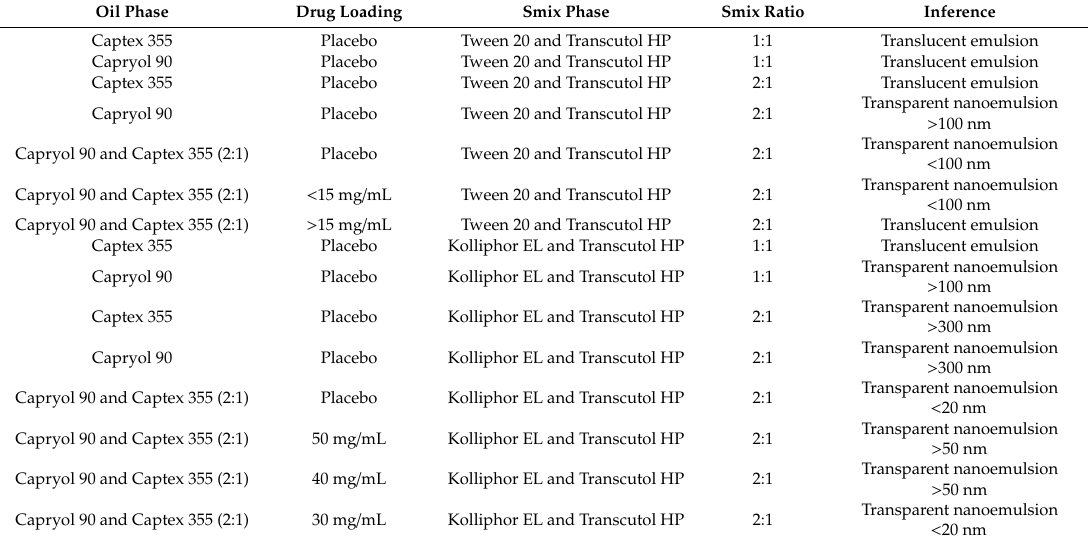
Table 2. Preformulation phase behavior study for the development of a retinyl palmitate-loaded nanoemulsion.